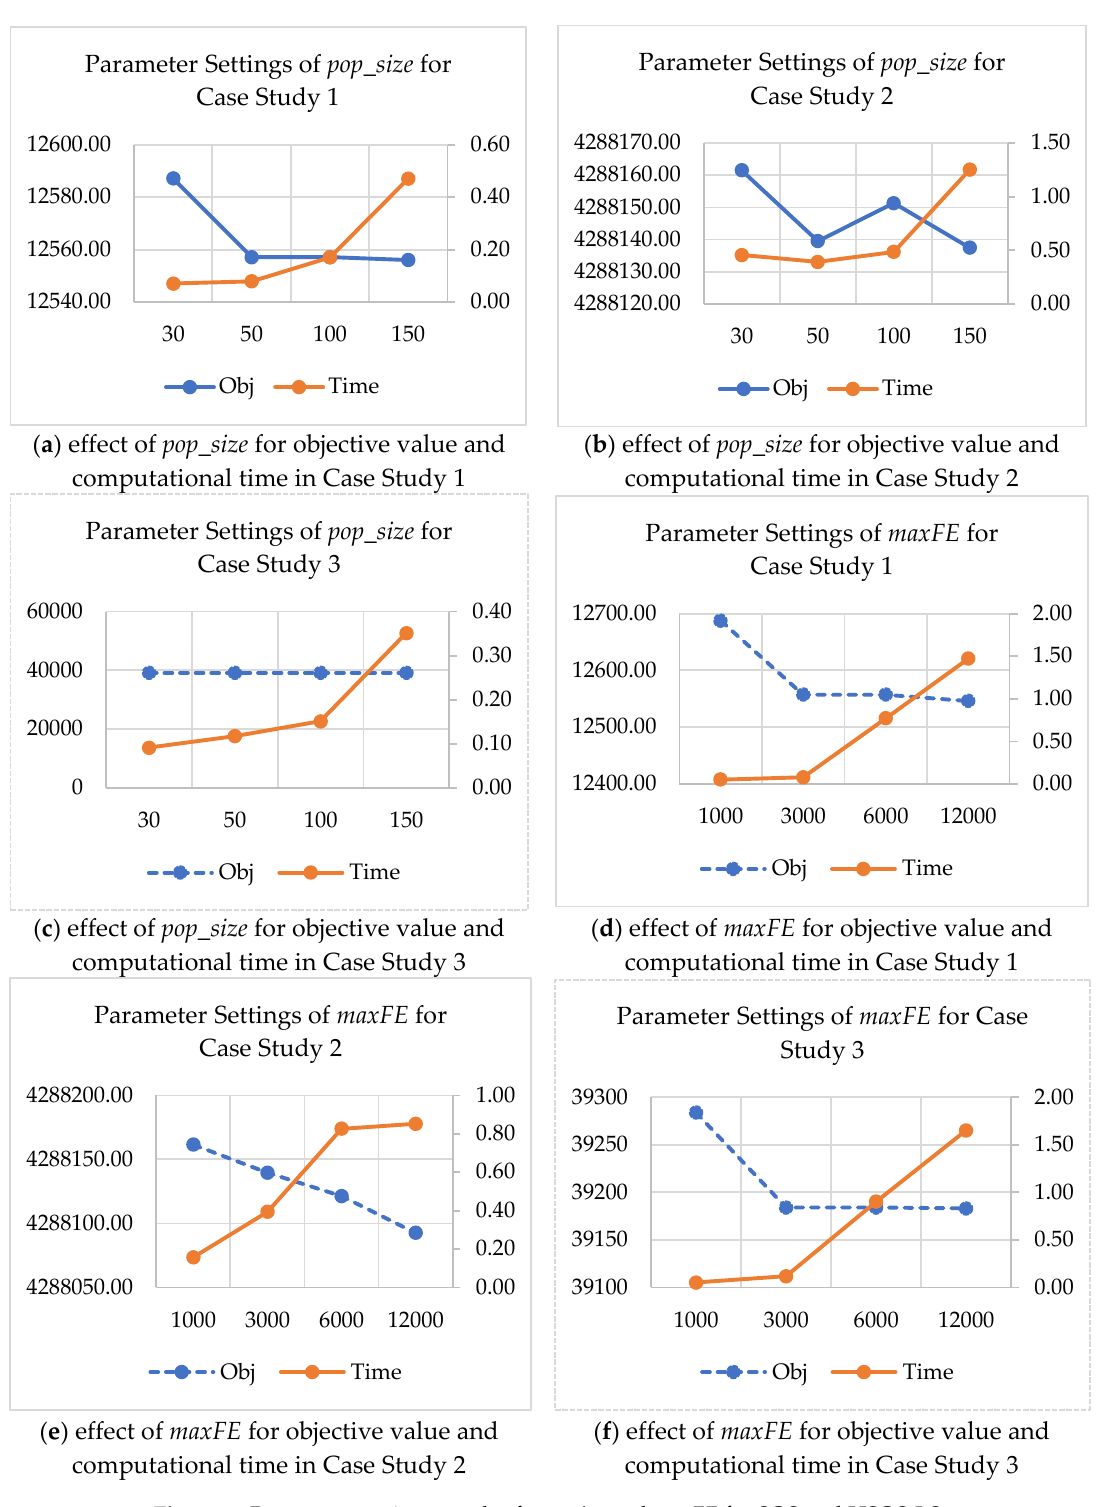
Figure 2. Parameter settings result of pop_size and maxFE for SOS and HSOS-LS.